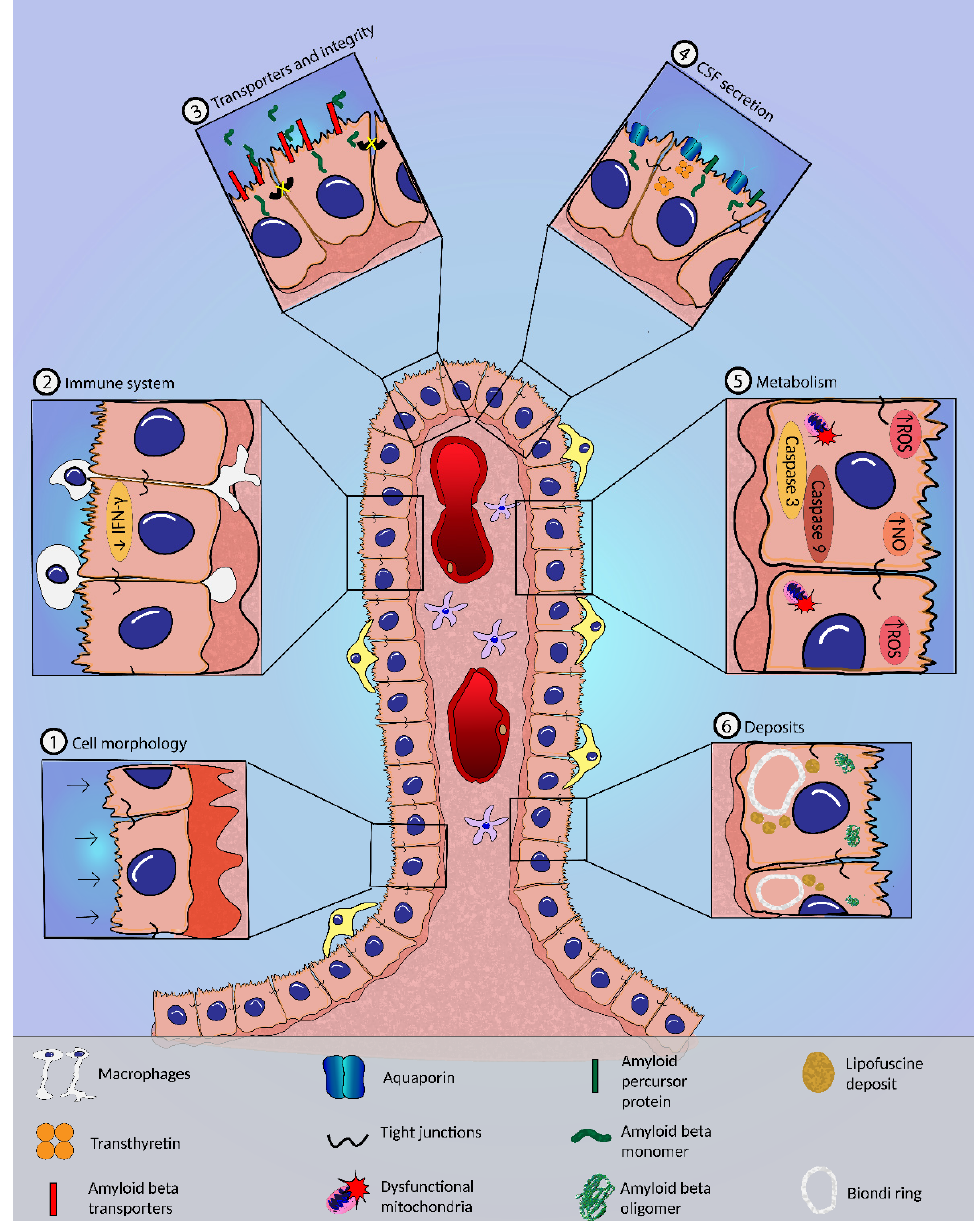
Figure 2. The choroid plexus (CP) and the blood–cerebrospinal barrier (BCSFB). The zoom high ‐ lights the alterations occurring in AD: (1) cell morphology—CP epithelial cell (CPEC) flattening